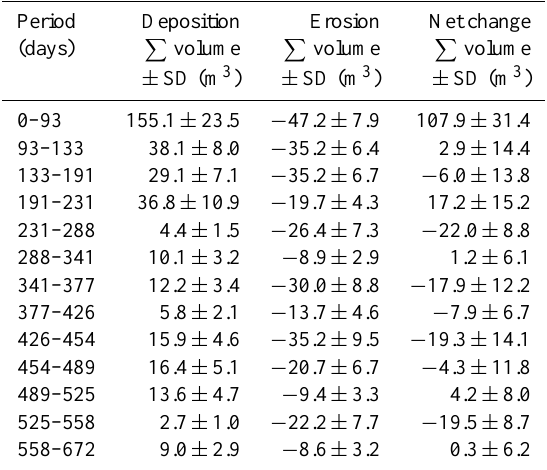
Table 2. Summary of volumetric change in storage by deposi- tion, erosion and net change (deposition minus erosion). Volumetric change is specified in gross change ( P volume) and the standard deviation (SD).